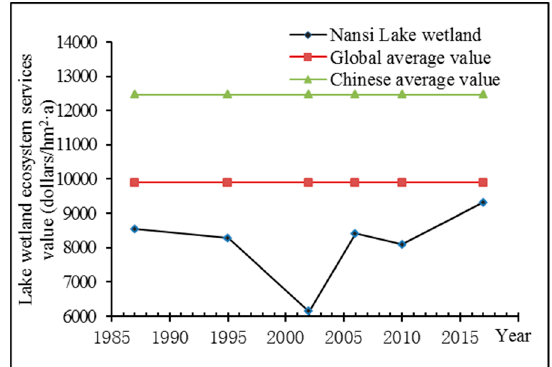
Figure 5. The comparison of the ESV in Nansi Lake wetland from 1987 to 2017.